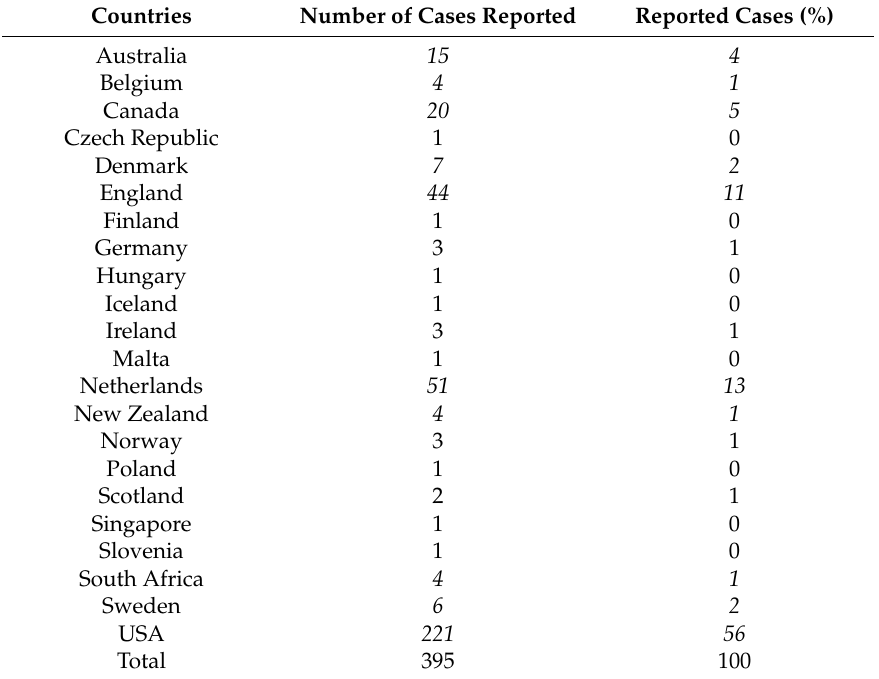
Table 4. Summary of pine nut syndrome (PNS) cases reported during